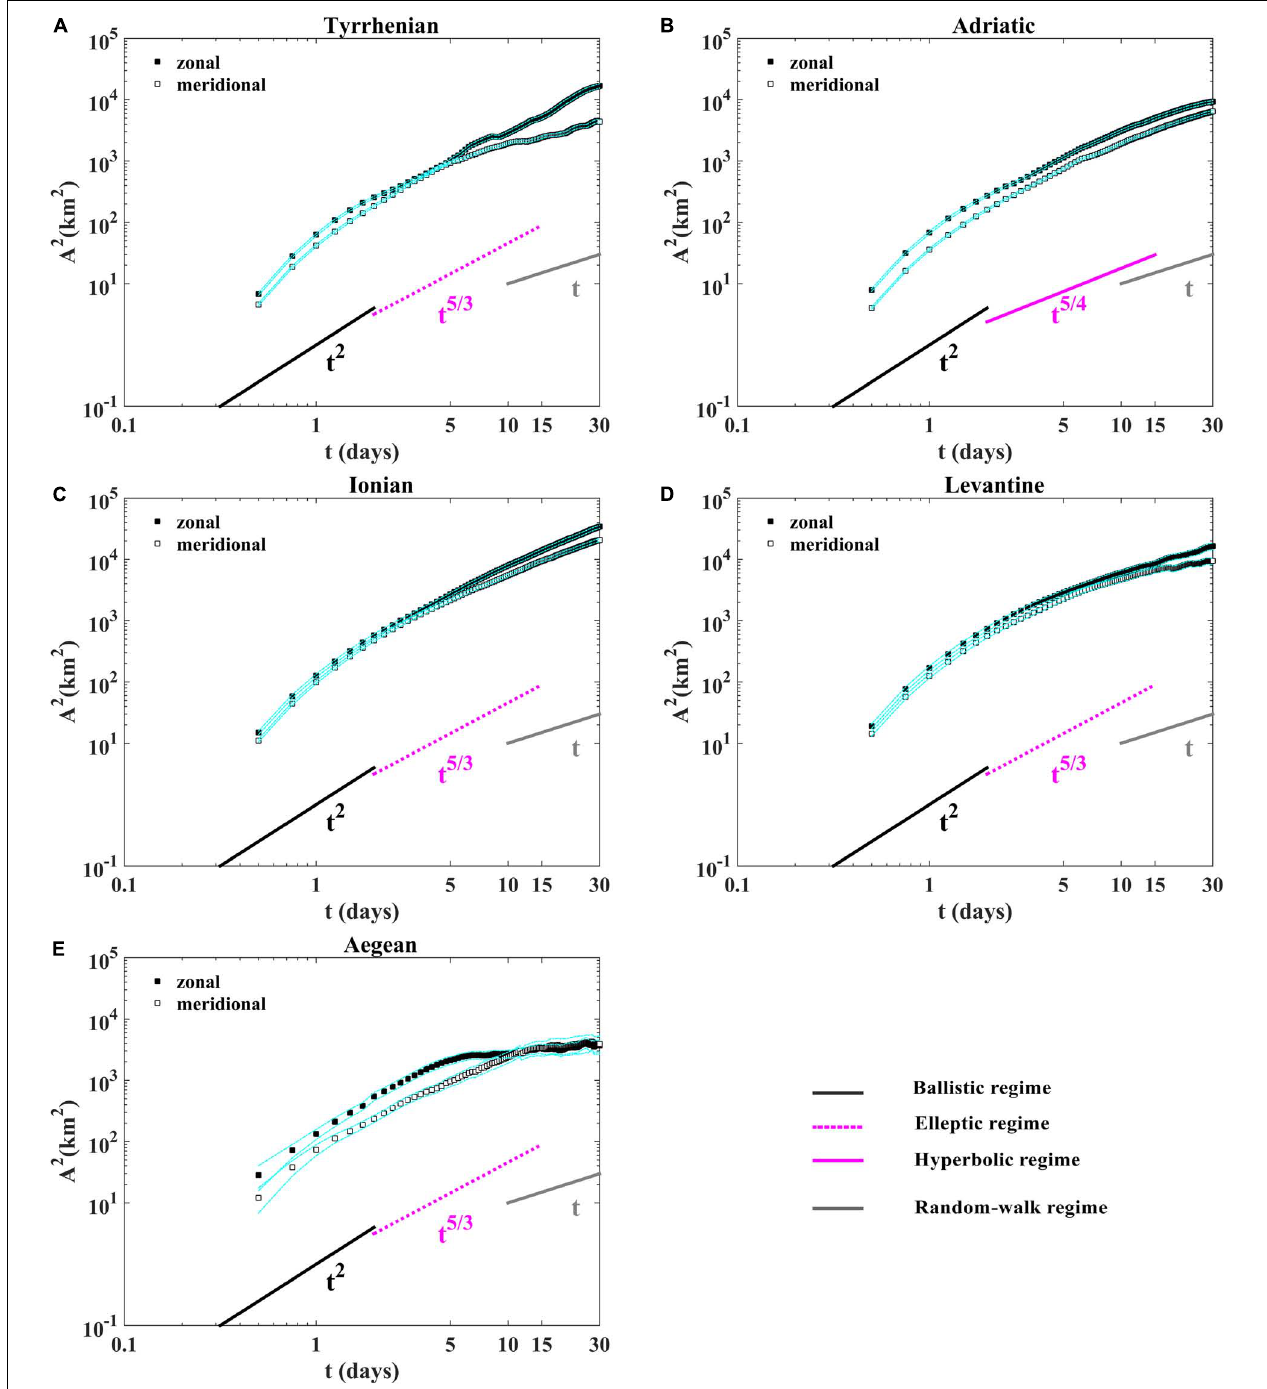
FIGURE 4 | Absolute dispersion for the zonal and meridional components as a function of time in loglog plot (A) in the Tyrrhenian, (B) the Adriatic, (C) the Ionian, (D) the Levantine, and (E) the Aegean sub-basins. The ballistic (black line) random-walk (gray line), the elliptic (dashed magenta line) and the hyperbolic (magenta full line) laws. The dashed cyan lines indicate the 90% confidence intervals from bootstrap resampling, give a rough idea of the uncertainties for the statistics.